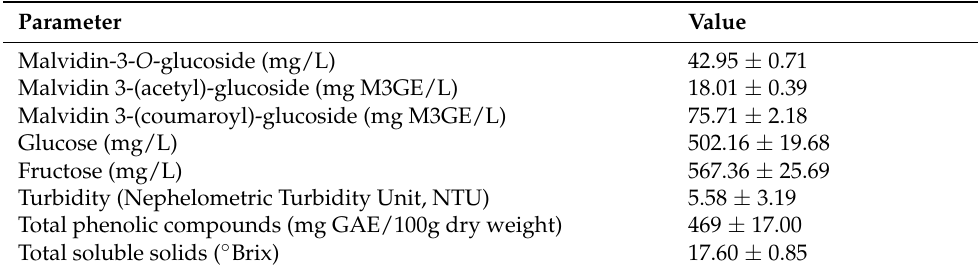
Table 1. Physico-chemical composition (mean ± standard deviation) of grape marc extract (M3GE, malvidin-3-glucoside equivalents; GAE, gallic acid